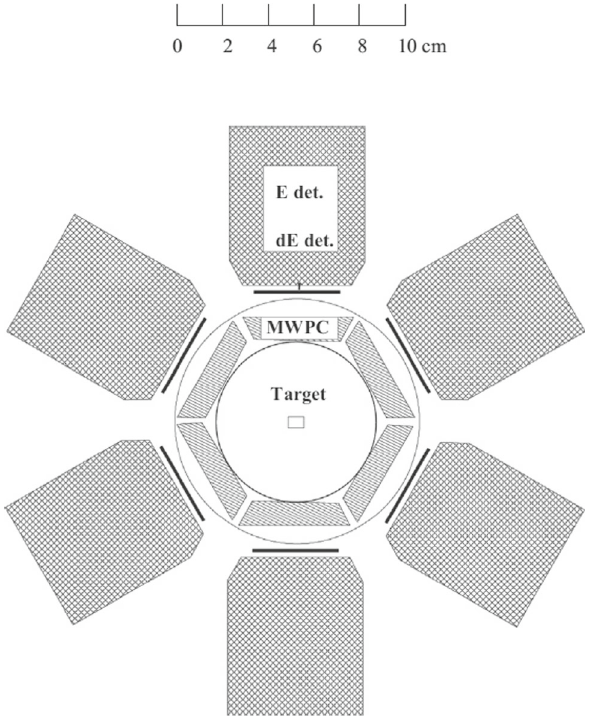
Fig. 1 The Atomki spectrometer layout